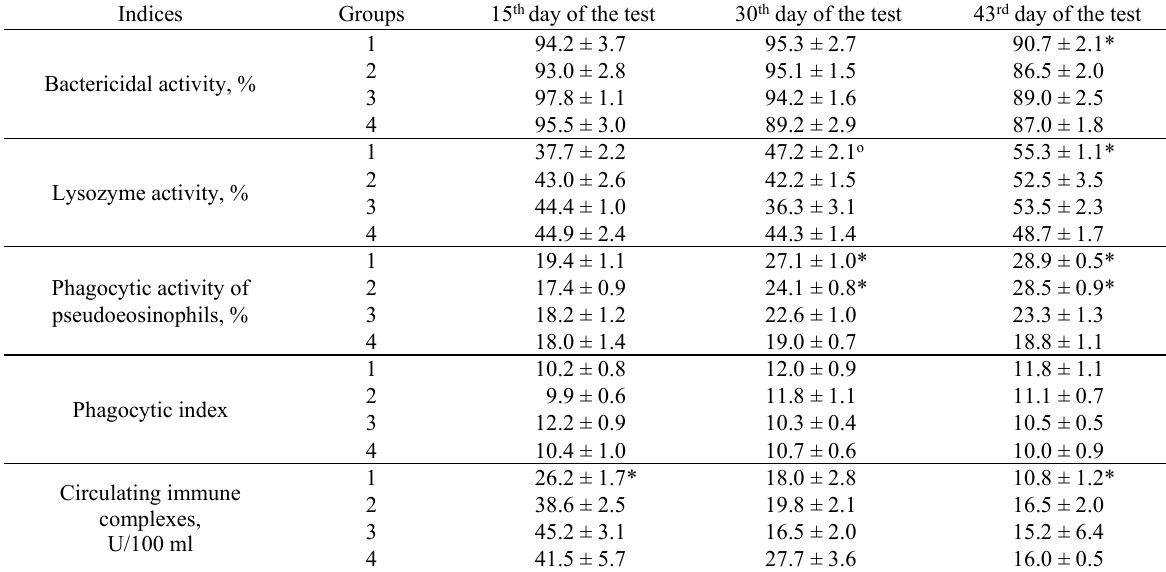
Indicators of nonspecific resistance of broiler chicken’s blood serum at the application of probiotic feed additives (M ± m, n = 10) Indices Groups Bactericidal activity,